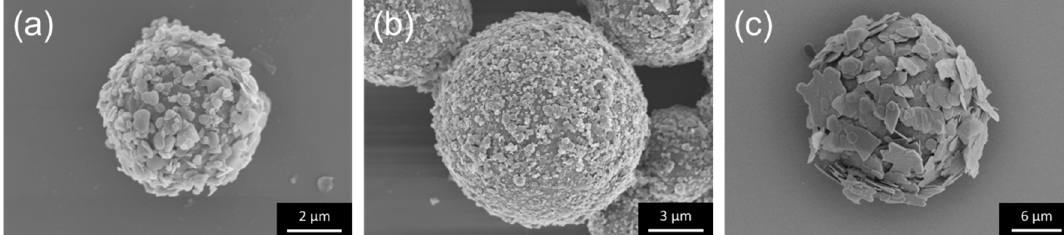
Figure 2. SEM images of the hBN / PMMA (PMMA core) composite particles obtained after electrostatic nano-assembly method using various sizes combination of ( a ) 0.5- µ m hBN on 5- µ m PMMA, ( b ) 0.5- µ m hBN on 12- µ m PMMA, and ( c ) 5- µ m hBN on 12- µ m PMMA.